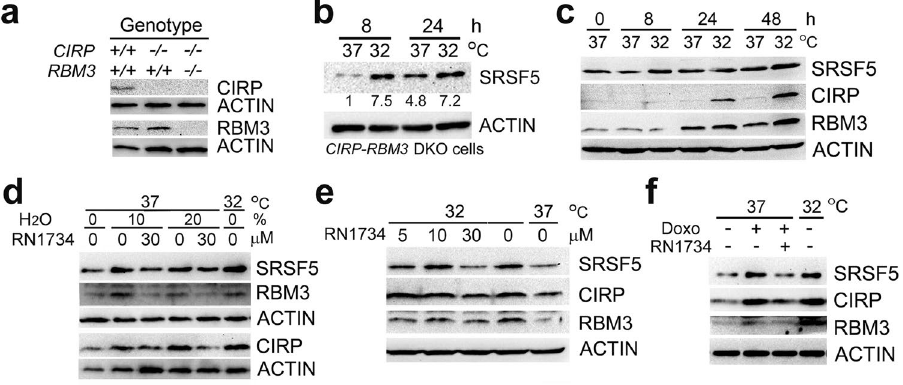
Figure 4. Regulatory mechanisms of SRSF5 induction. ( a and b ) Fibroblasts from wild-type ( + / + ) or knockout ( − / − ) mice were analyzed for expression of CIRP and RBM3 by western blot (representative of 2 independent experiments) ( a ). CIRP-RBM3 double knockout (DKO) fibroblasts were cultured at 37 °C or 32 °C for 8 or 24 h, and analyzed by western blot. Relative band intensities after normalization to ACTIN expression are shown below the panel (representative of 2 independent experiments) ( b ). ( c ) B22 cells were cultured at 37 °C or 32 °C for indicated times, and analyzed by western blot (representative of 3 independent experiments). ( d ) U-2 OS cells were incubated with isotonic regular media (0%) or hypotonic media containing 10 or 20% (volume/ volume) of